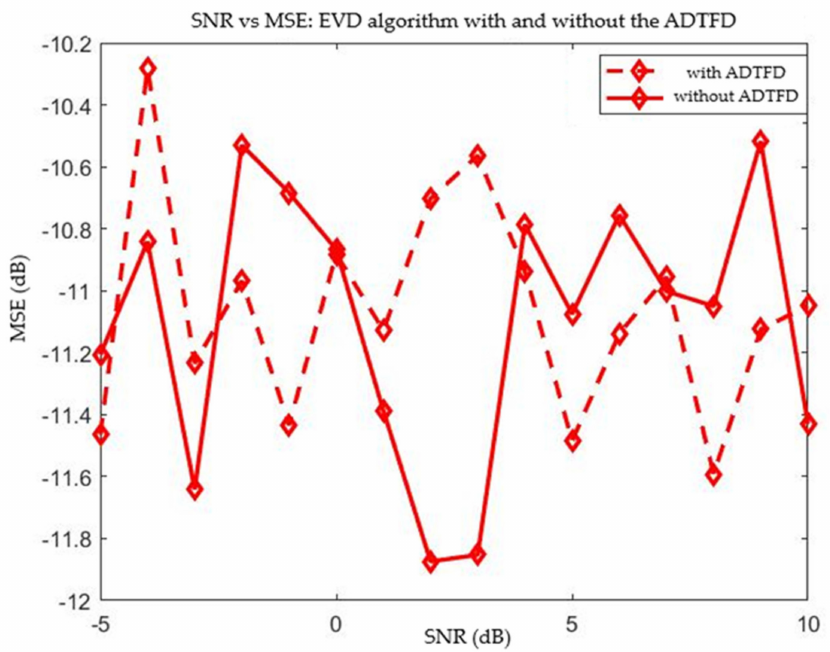
Figure 9. SNR vs. MSE plot of the EVD algorithm with and without ADTFD (solid line and the dashed line represent the cases without ADTFT and ADTFD,